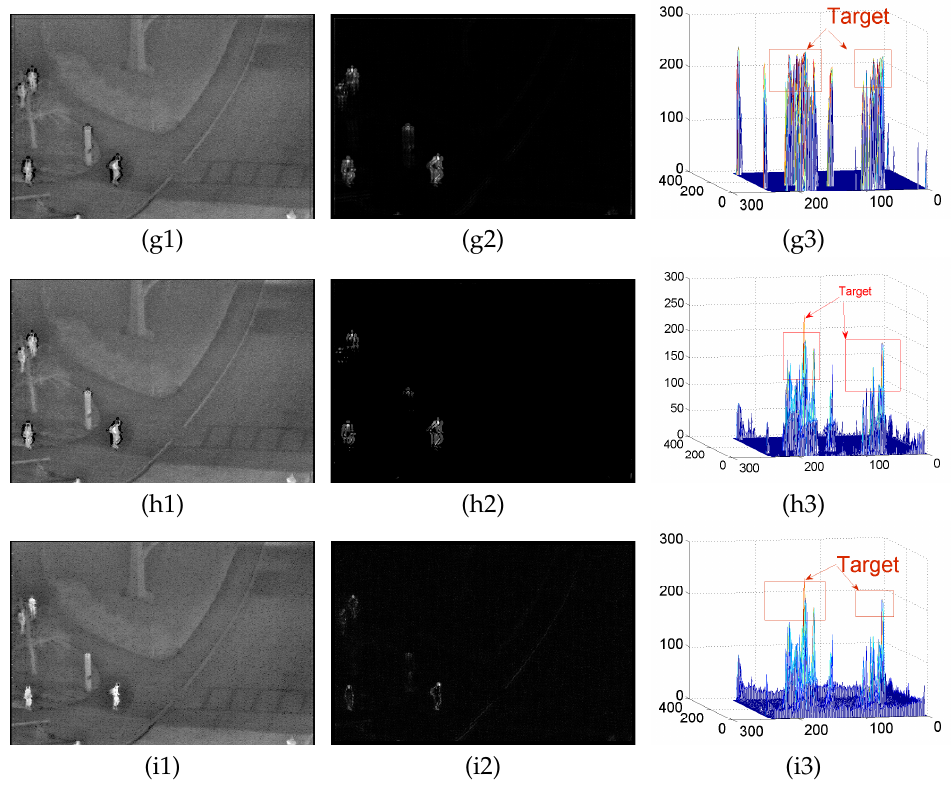
Figure A1. ( a – i ) denote the detectionresults of the PSTNN, RPCA, TV-PCP, VNTFR, ASTTV, SRWS, C2, C3, and proposed algorithm on sequence B, respectively, where ( a1 – a3 ) denote the background map, the differential map, and the 3D map of the obtained differential map, respectively.